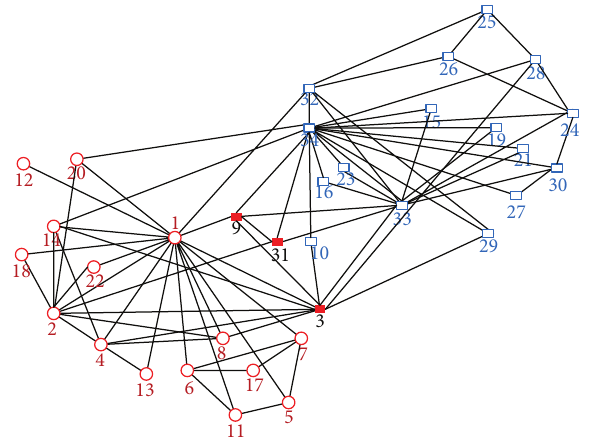
Figure 7: The community structure found by our algorithm in Protein reaction